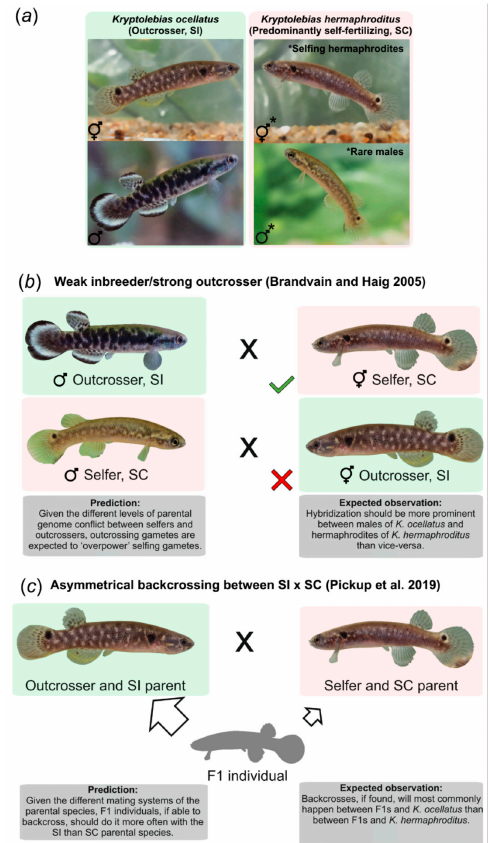
Figure 1. Mangrove killifish species and schematic representation of predictions and expected obser- vations. ( a ) Mangrove killifish species with respective mating systems. Mating system classifications for Kryptolebias ocellatus and K. hermaphroditus mating were retrieved from [33,35], respectively. ‘SI’ refers to self-incompatible. ‘SC’ denotes self-compatible. ( b ) Representation for the weak inbreeder, strong outcrosser hypothesis (WISO) [11]. This hypothesis predicts that outcrossers have higher potential for genome conflict given the higher likelihood of crossing between divergent genomes when compared to selfers. This higher potential for genome conflict should reflect on the level of gametes competitiveness with outcrossers gametes being able ‘overpower’ selfers gametes [11]. Thus, the prediction is that hybridization between species with different mating systems should occur more often between males of the outcrossing species with hermaphrodites of selfers (as competitive sperm should overcome the potential reproductive barrier imposed by the less competitive selfers eggs). The opposite direction is less likely to happen as outcrossers’ eggs should impose a stronger barrier for the less competitive sperm from selfers. ( c ) Representation for asymmetrical backcrossing between SI and SC hypothesis [5]. Given the differences between parental mating systems, if F1 individuals are viable and able to backcross, the direction of backcrossing should be biased towards the SI parent (higher gametes transmission) rather than the SC (gametes partially fertilized through selfing)